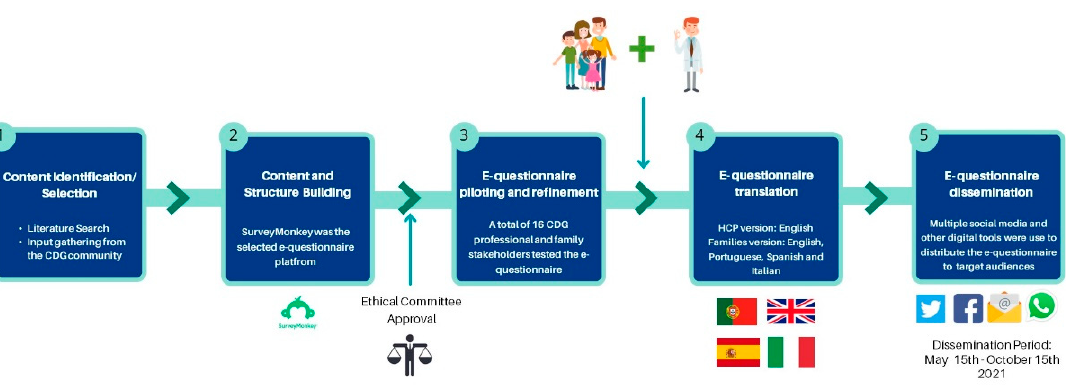
Figure 1. Development, refinement, and distribution of the CDG Journey Mapping